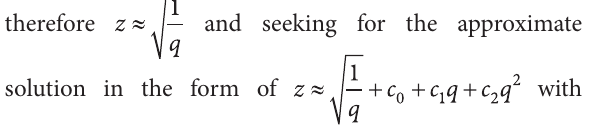
Fig. 4. The graphs of the function f ( z ) and the inverse (solution) f –1 ( q )